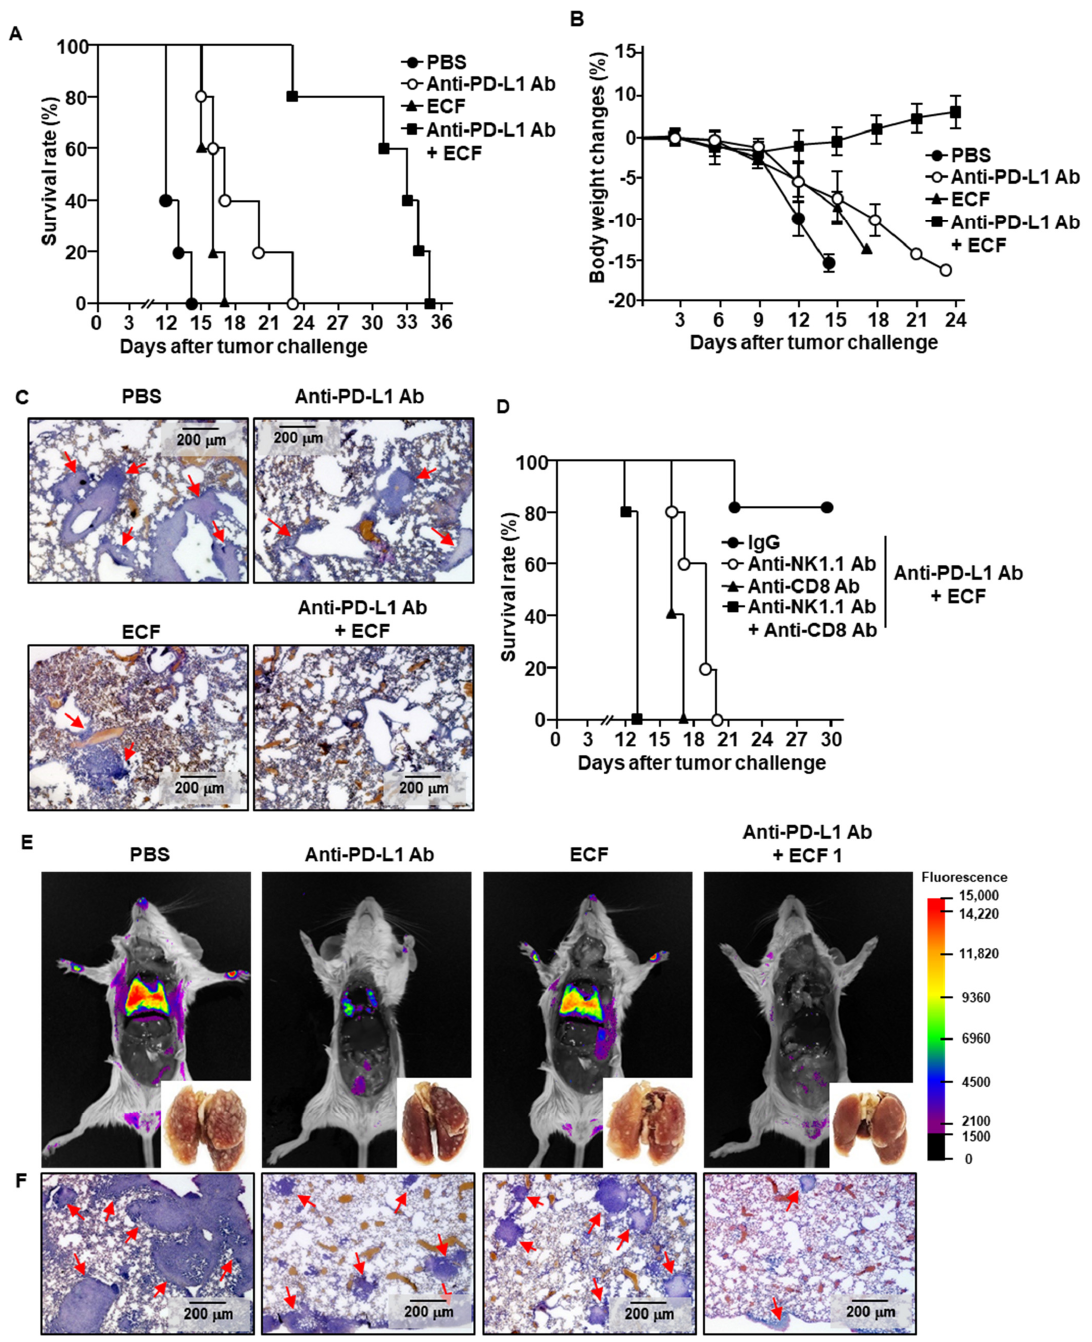
Figure 5. ECF enhances anti-PD-L1 antibody-induced anti-cancer immunity. C57BL/6 mice were challenged intravenously ( i . v .) with 0.5 × 10 6 B16 cells. As indicated in the materials and method, the mice were treated with PBS 10 mg/kg of anti-PD-L1 antibody (Ab), 50 mg/kg of ECF and the combination of ECF and anti-PD-L1 Ab. ( A ) The graph showed survival rate of treated mice ( n = 5 for each group). ( B ) Changes of body weight during treatment were shown. ( C ) Hematoxylin and eosin (H&E) staining of lung showed B16 melanoma cell infiltration, as analyzed on day 10 after tumor injection. Red arrows indicated infiltrated tumor cells. ( D ) Survival rate, as measured in natural killer (NK)- or CD8 T cell-depleted mice ( n = 5 for each group). ( E , F ) BALB/c mice were injected i . v . with 0.5 × 10 6 CT-26-iRFP cells. The mice received with PBS, 10 mg/kg of anti-PD-L1 Ab, 50 mg/kg of ECF or the combination of anti-PD-L1 Ab and ECF for a 3 day-interval. ( E ) Fluorescence imaging of iRFP in the mice on day 14 after CT-26-iRFP cell administration in BLAB/c mice, n = 5. ( F ) CT-26 cell infiltration in lung was analyzed by H&E staining of lung tissue 14 days after CT-26 injection in BALB/c mice. Red arrows indicated infiltrated tumor